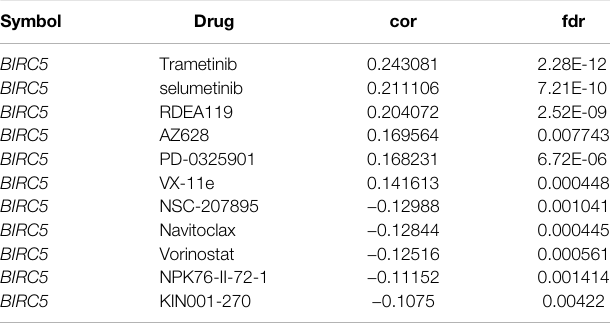
TABLE3| Analysisofthecorrelationbetween BIRC5 expressionanddiversedrug sensitivity by using GDSC database. Symbol Drug